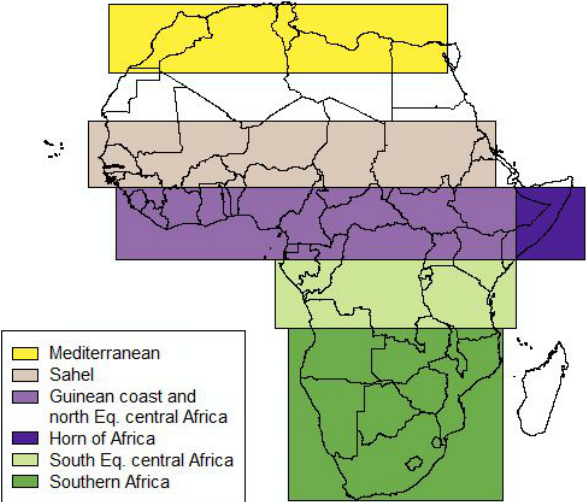
Fig. 3. Derived “regions” characterized by both the regional loca- tion and the climatic class within the